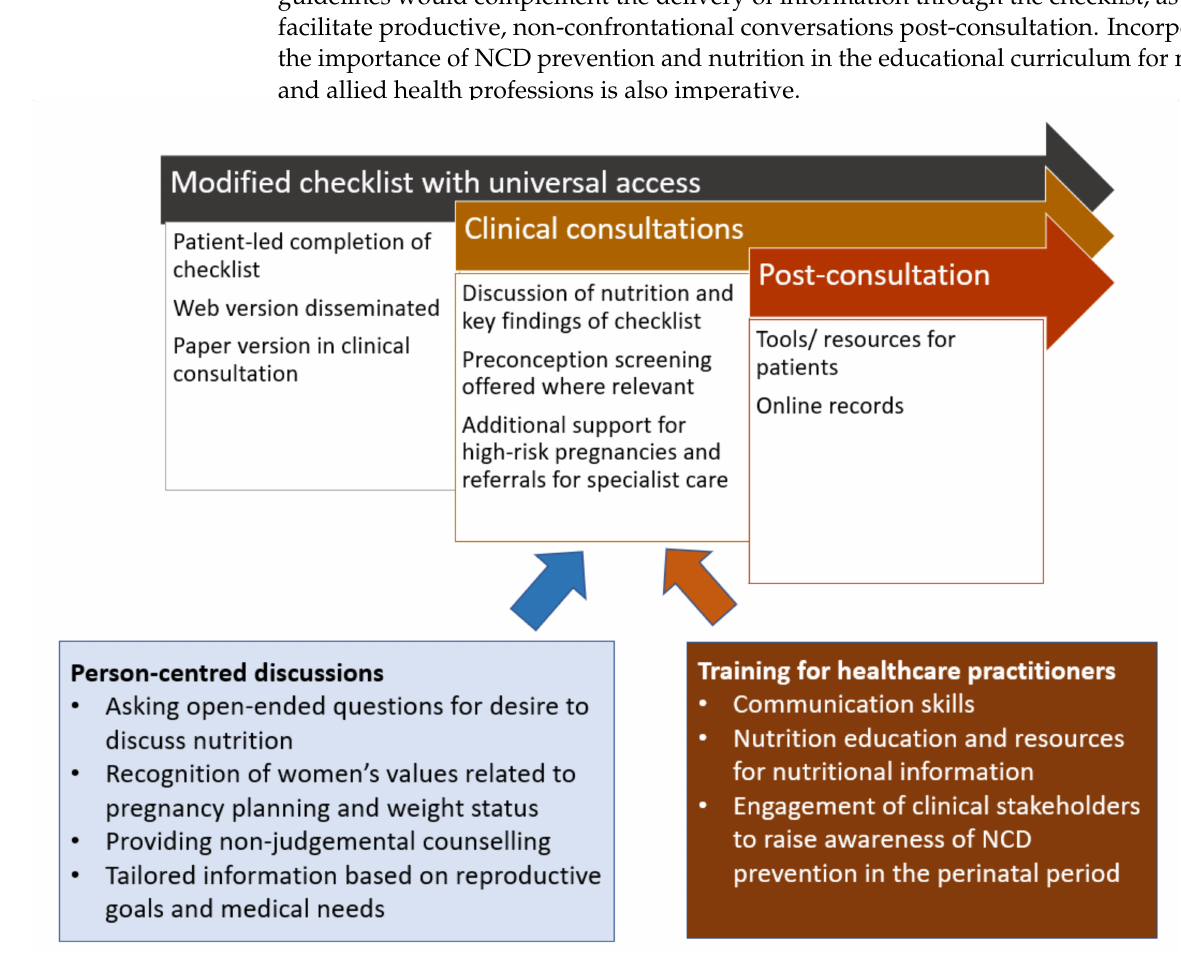
Figure 6. Recommendations for implementing the modified checklist during clinical visits. NCD, non-communicable